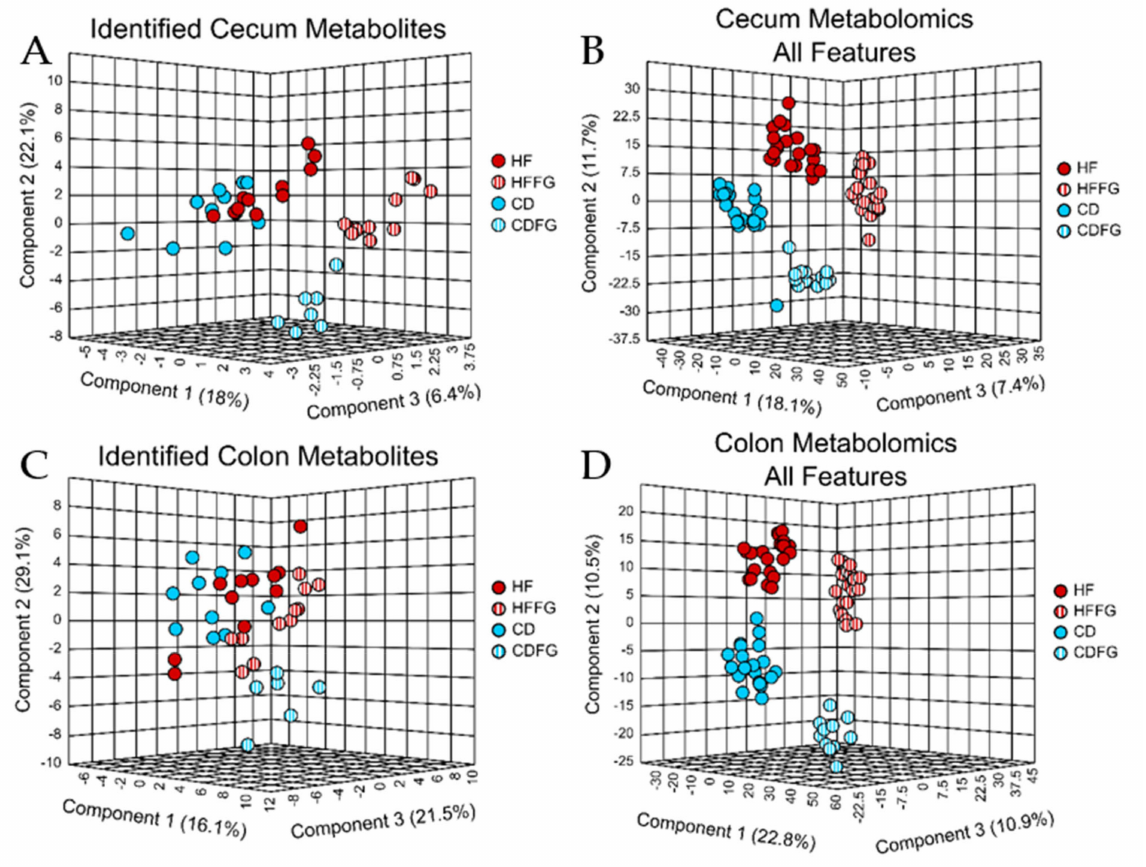
Figure 3. Diet and FG supplementation induce distinct differences in the large intestine metabolome as shown by PLS-DA. Untargeted metabolomics was performed on the cecum and colon contents of mice fed either HF, HFFG, CD, or CDFG diets after 14 weeks of diet exposure. PLS-DA were performed for ( A ) identified cecum metabolites, ( B ) all cecum spectral features, ( C ) identified colon metabolites, and ( D ) all colon spectral features. Cross validation values can be found in Supplemen- tary Table S1. Experimental replicates are shown; HF samples are shown in red, HFFG samples are shown in red stripes, CD samples are shown in blue, and CDFG samples are shown in blue